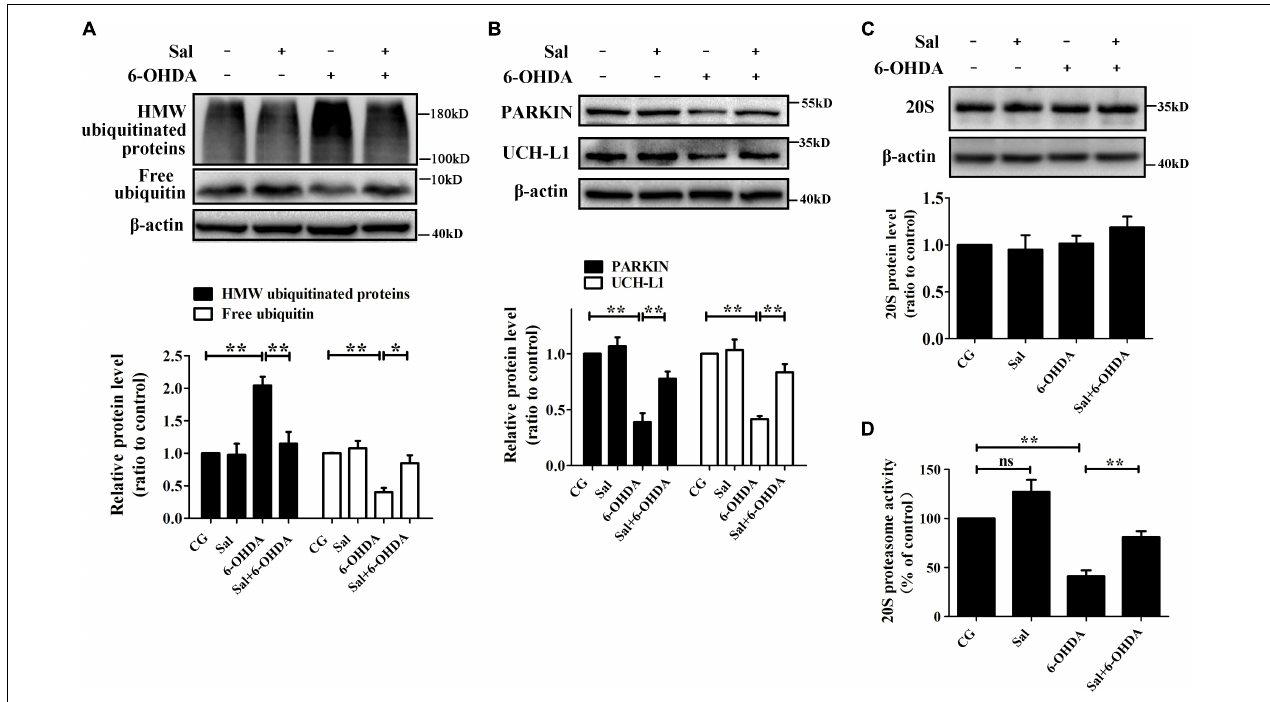
FIGURE 3 | Sal protected the UPS from 6-OHDA-induced dysfunction in SH-SY5Y cells. Cells were preincubated with Sal (40 µ M) for 24 h, then exposed to 6-OHDA (100 µ M) for another 24 h. Immunoblot levels of highly molecular weight (HMW)-ubiquitinated proteins, free ubiquitin (A) , PARKIN, Ubiquitin C-terminalhydrolase-L1 UCH-L1 (B) , and 20S Proteasome core subunits (C) ; (D) Proteasome activity assay analysis of 20S proteasome activity. Data are shown as the mean ± SEM. Statistical significance was analyzed by one-way analysis of variance (ANOVA). A two-tailed Student’s t -test was performed for comparisons between two groups. Each experiment was repeated three times independently. ∗ P < 0.05; ∗∗ P < 0.01, ns: no